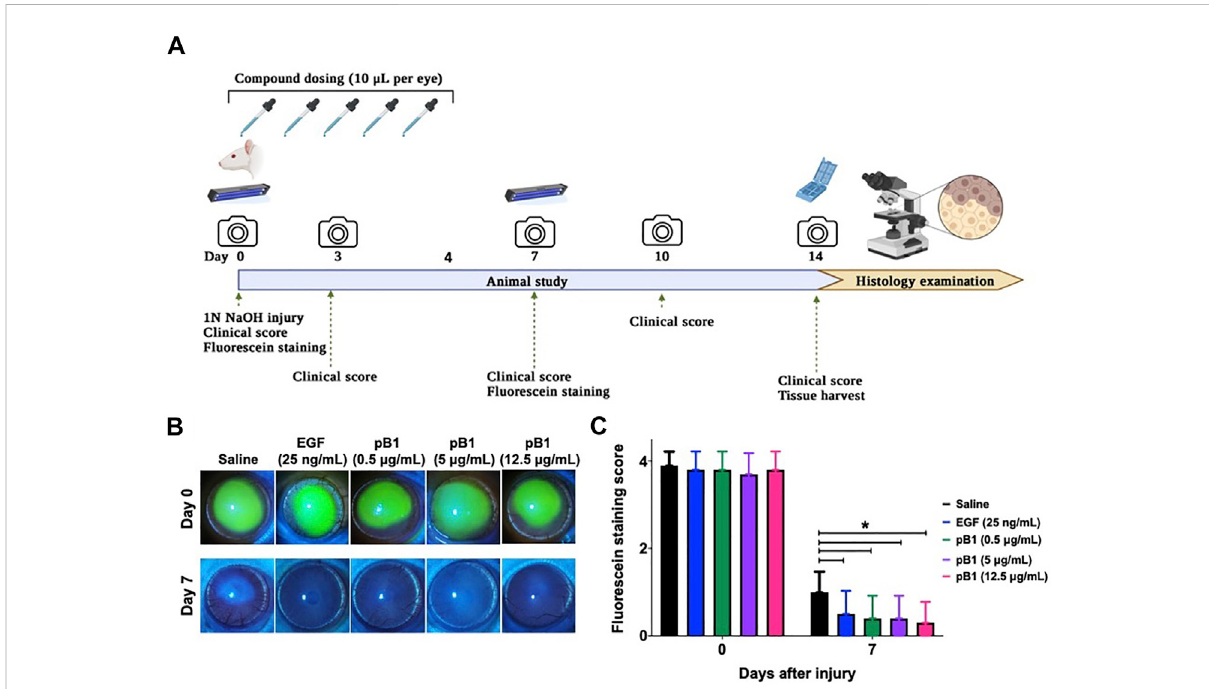
FIGURE 3 Bleogen pB1 accelerates corneal wound healing in male Wistar rats after a burn caused by NaOH. (A) Treatment regimen of the acute corneal alkali injury model. In total, 50 rats were subjected to acute alkali burn injury to the right eye by placing a piece of 3.2-mm-diameter fi lter paper soakedin1 NNaOHfor30 sontheeye.Aftertheinjury,theratswereseparatedinto fi vegroups:(1)salinecontrol(10rats),(2)EGF(25 ng/ml;10rats), (3) pB1 (0.5 μ g/ml; 10 rats), (4) pB1 (5 μ g/ml; 10 rats), and (5) pB1 (12.5 μ g/ml; 10 rats). Ophthalmic application of the test compounds was performed for fi ve consecutive days after the induction of the injury. Fluorescein staining was performed on days 0 and 7 after the injury in order to assess the corneal epithelial damage. On days 0, 3, 5, 7, 10, and 14 after the injury, both the corneal opacity and the neovascularization were examined. (B) Representative photographs of the wound area on days 0 and 7 after the injury as de fi ned through fl uorescein staining. (C) Bar charts showing the fl uorescein staining score of all corneal injury groups. All results are expressed as the mean ± standard deviation (SD); * p < 0.05 for all treated groups, as compared with the saline control group. Notes: EGF: epidermal growth